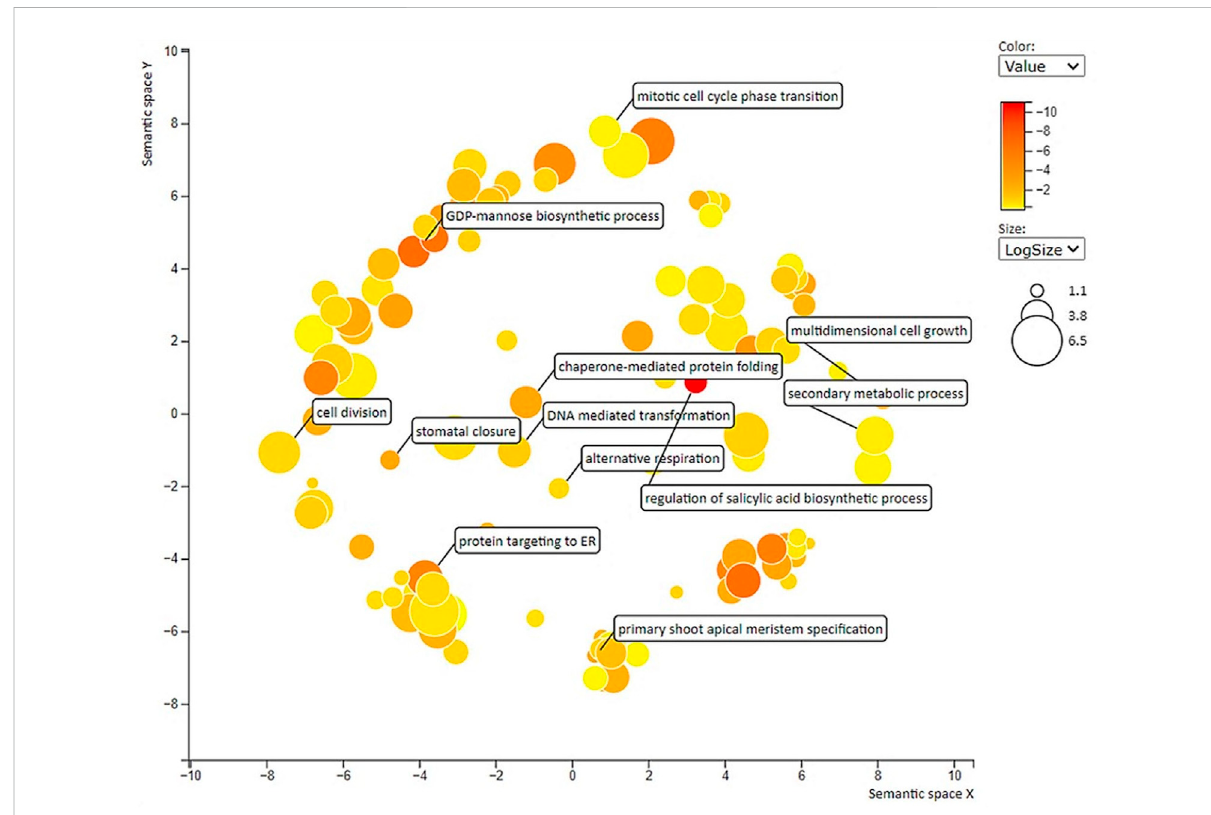
FIGURE 4 Scatter plot showing overrepresented GO term (p < 0.01) in all comparisons with labels having seed-size responsive terms. Different shades in circles indicate the difference in p -values (as given in the scale), whereas the bubble size indicates the frequency of the GO